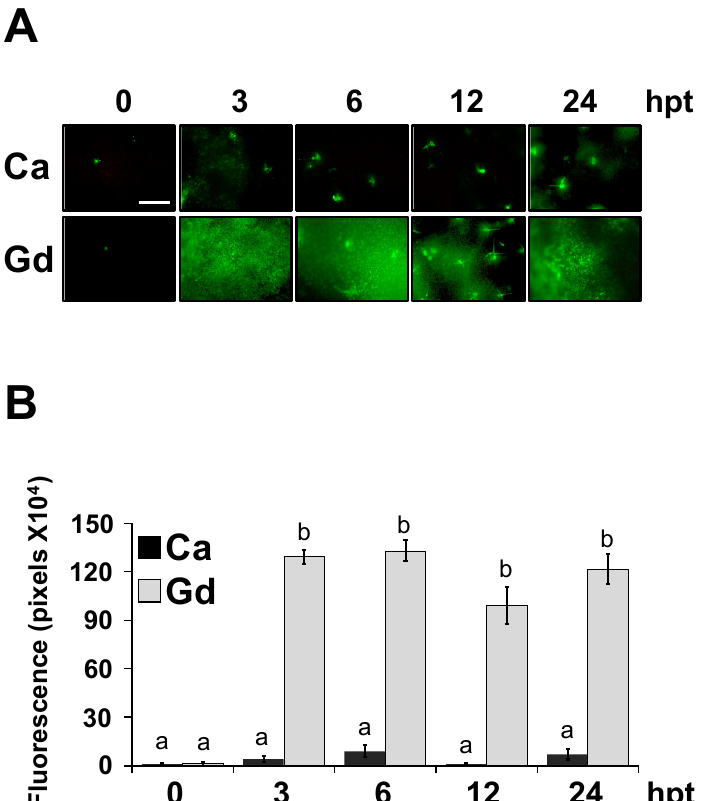
Figure 5. Gd-induced accumulation of ROS. ( A ) Leaves from 4-week-old A. thaliana plants treated with 0.2 g/L of Ca or Gd were stained using DCF-DA to detect basal ROS levels at the indicated time point ( B ) Densitometric quantification of ROS production at indicated time points after Ca or Gd treatment. Bars represent the mean values ( ± SD) of three independent experiments ( n = 30). Different letters above each bar represent statistically significant differences according to the Scott–Knott test ( p < 0.05). Scale bar = 200 μ m.